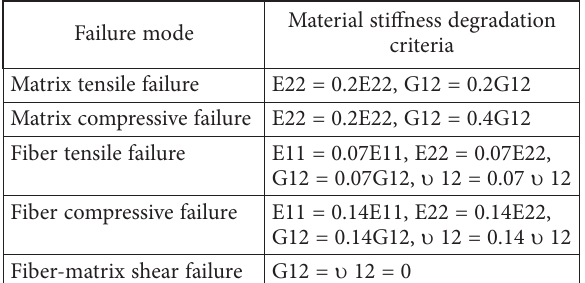
Table 1. Stiffness degradation